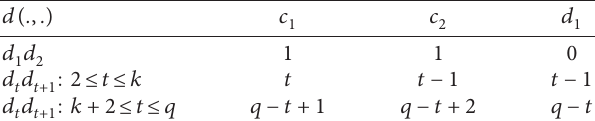
Table 9: Codes of inner edges of GP ( q, 1 )